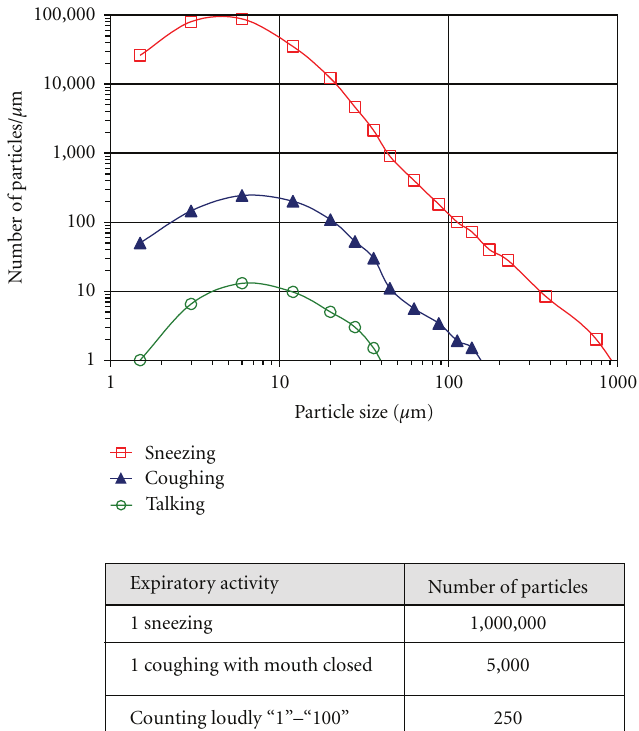
Figure 3: Number of particles normalized for interval width produced by human expiratory activities as a function of particle size—based on data from Duguid [34].